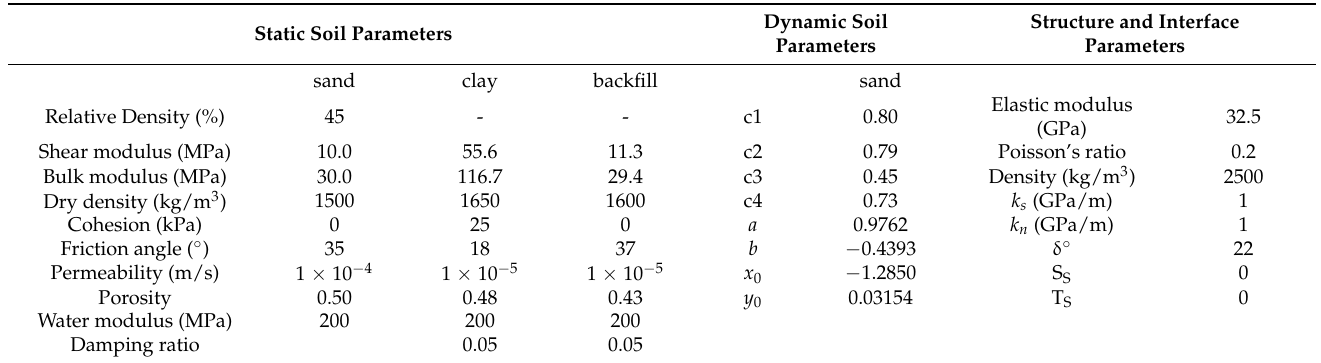
Table 1. Material parameters used in the numerical